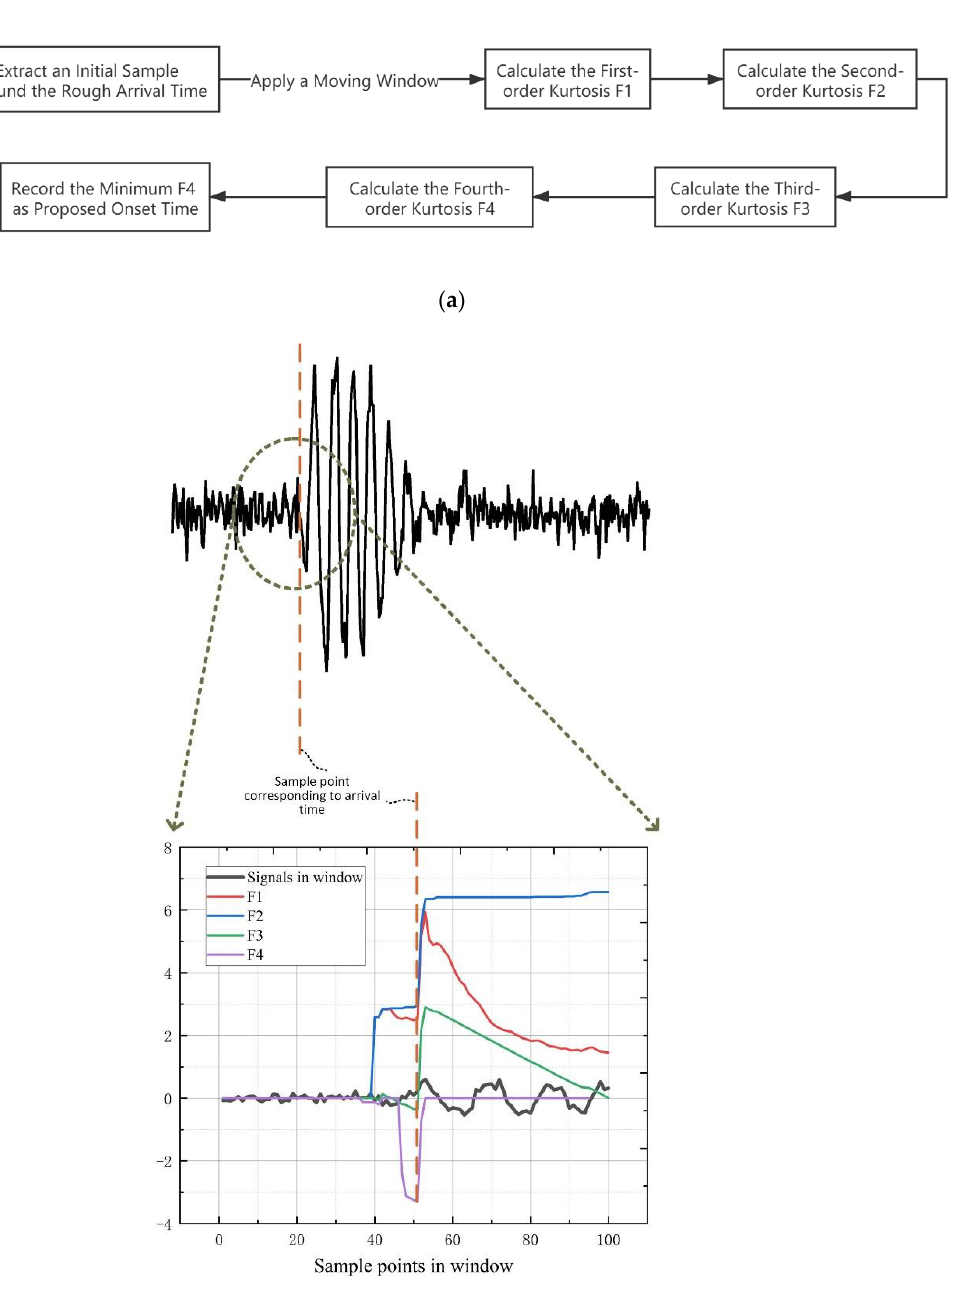
Figure 4. ( a ) Flowchart of carrying out kurtosis characteristic function calculation; ( b ) values of F 1 , F 2 , F 3 , and F 4 around onset time, minimum fourth-order kurtosis corresponding to the onset time.